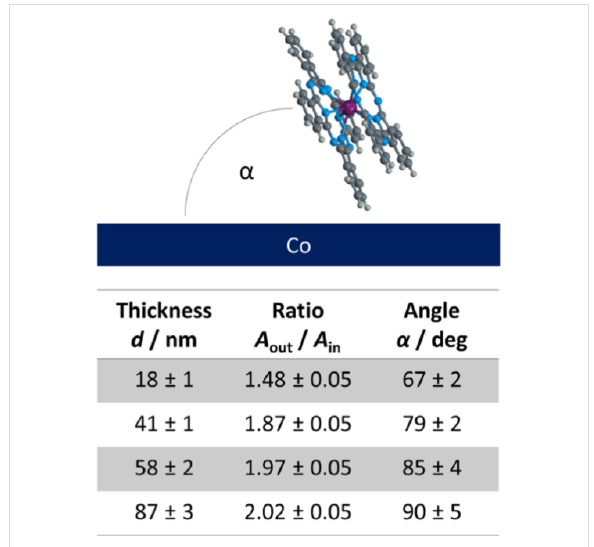
Figure 3: Definition of the molecular tilt angle (top). Average tilt angle of the TbPc 2 molecules on cobalt (bottom). The thickness of the films was estimated from the ellipsometry